Question: Express in one sentence what the figure is showing.
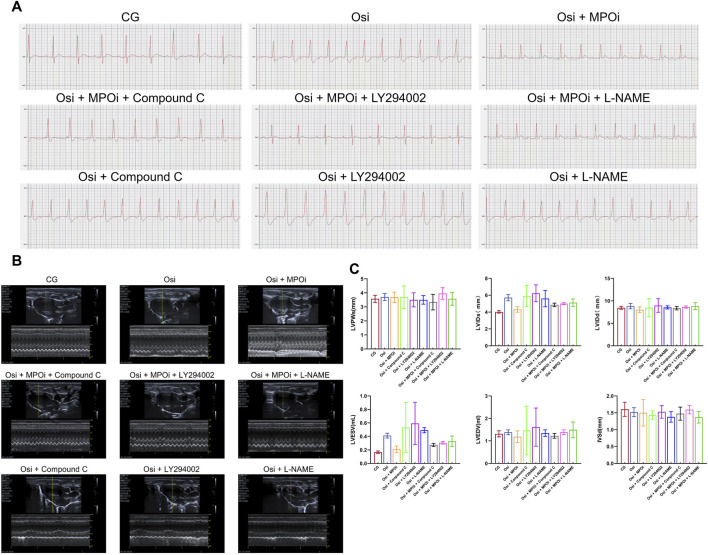
Answer: ECG and echocardiographic results of SD rats in various treatment groups. (A) : Electrocardiogram images of each group; (B) : Echocardiographic images of each group; (C) : Histograms of cardiac ultrasound related indicators in each group.